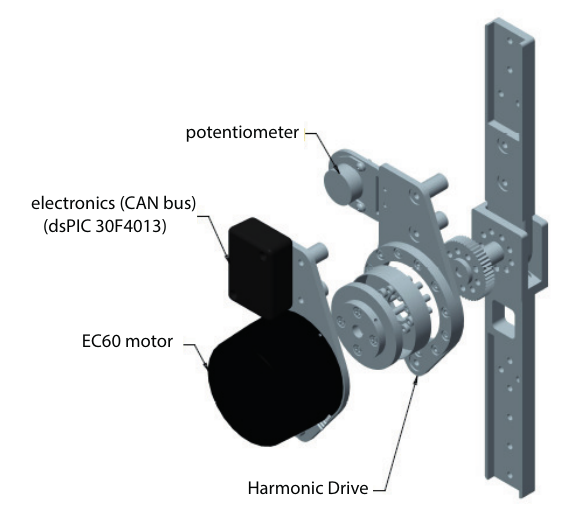
Figure 3. Exploded view of a joint actuation module. CAN: Controller Area